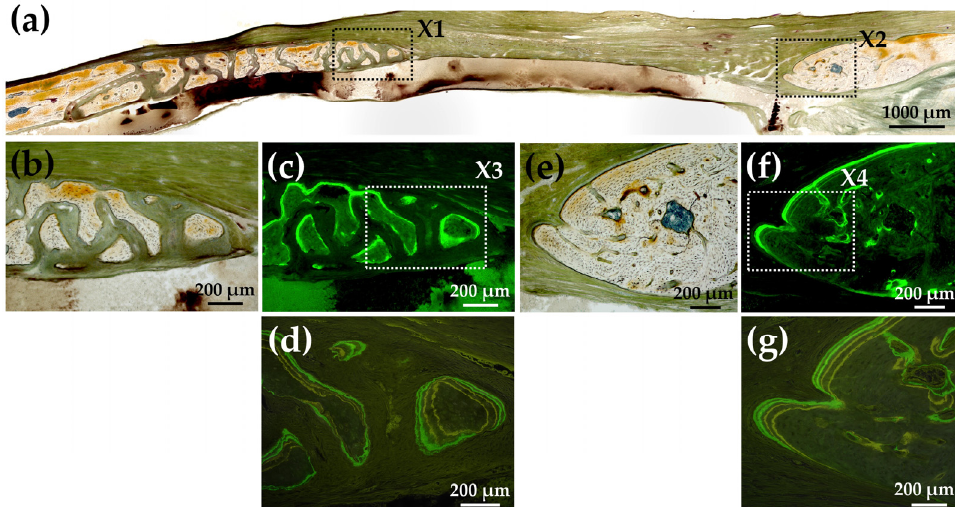
Figure 16. ( a ) Villanueva-stained image of a rat cranial bone defect filled with another AG-infiltrated and b-FGF-loaded Col/Hap composite (AI 60 min 5Cy Col/Hap + AG + b-FGF) (4× magnification). ( b ) Magnified image of “X1” in Figure 16a. ( c ) CL-fluor-labeled image of Figure 16b (10× magnifica- tion). ( d ) Magnified TC&CL-fluor-labeled image of “X3” in Figure 16c (20× magnification). ( e ) Mag- nified image of “X2” in Figure 16a. ( f ) CL-fluor-labeled image of Figure 16e (10× magnification). ( g ) Magnified TC&CL-fluor-labeled image of “X4” in Figure 16f (20× magnification).